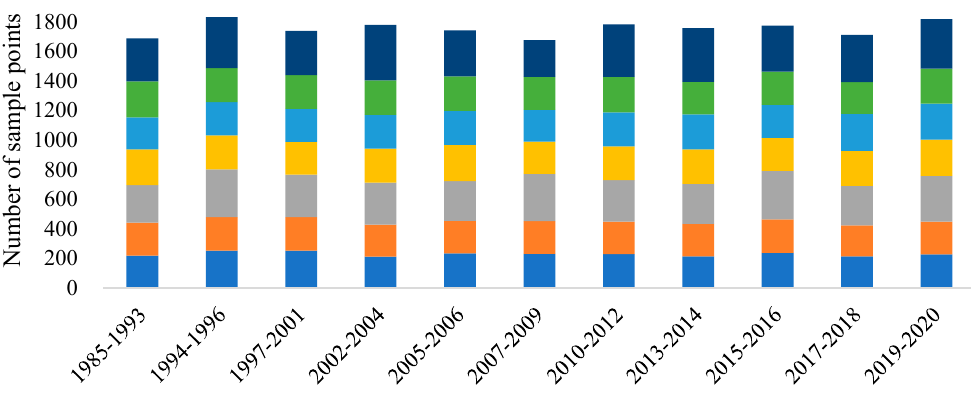
Figure 4. Sample points for each period. The clean glacier, water body, and others are the first classification samples and the debris-covered glacier, snow, water body (2), and others (2) are the second.